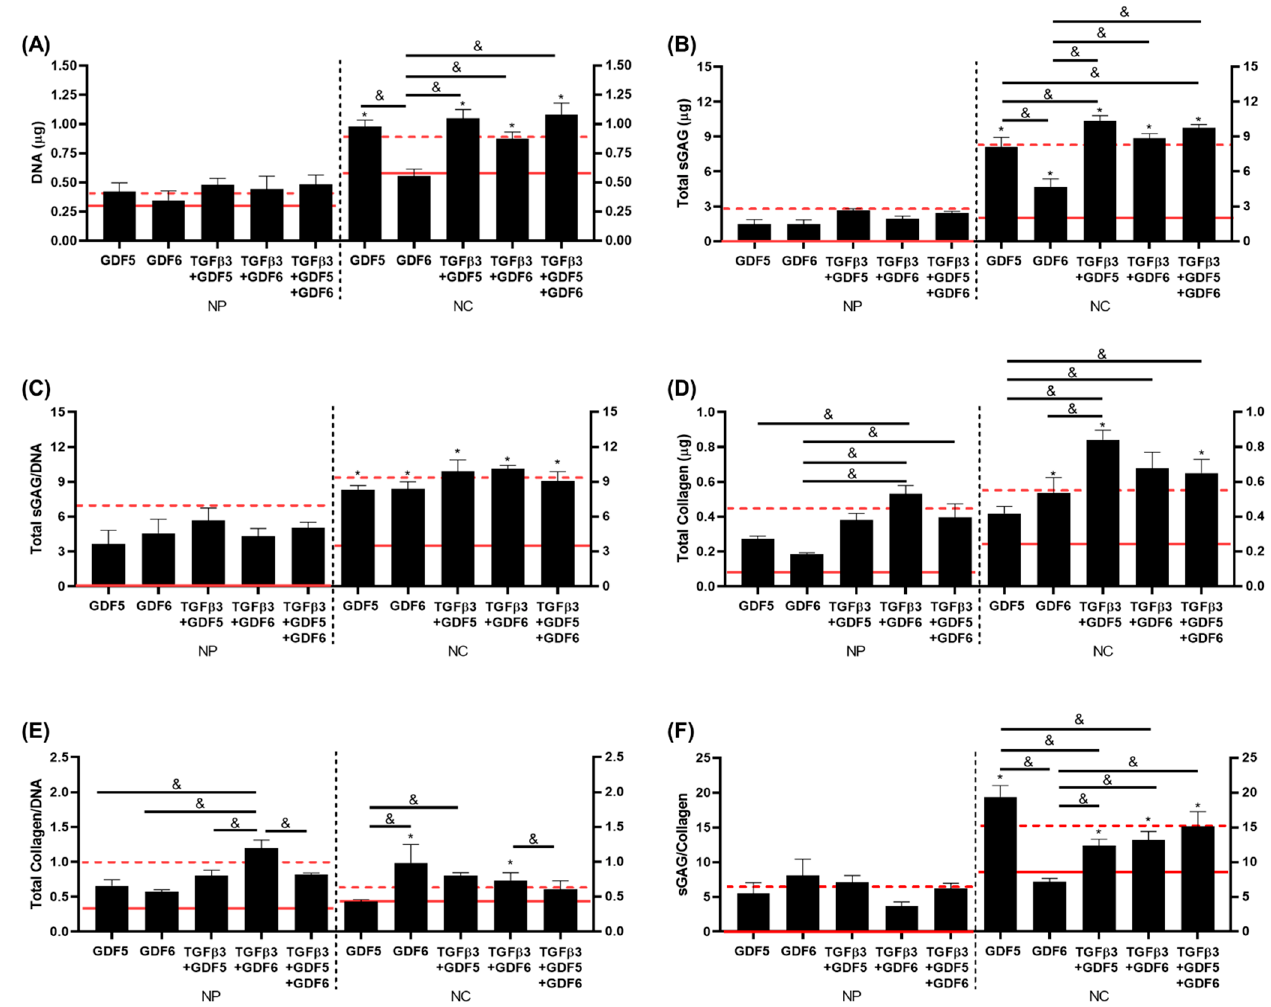
Figure 6. Biochemical analysis of nucleus pulposus (NP) and nasoseptal chondrocyte (NC) micro- tissues stimulated with GDF5, GDF6, TGF β 3 + GDF5, TGF β 3 + GDF6, TGF β 3 + GDF5 + GDF6 on day 7. ( A ) DNA ( µ g), ( B ) Total sGAG ( µ g), ( C ) Total sGAG/DNA, ( D ) Total Collagen ( µ g), ( E ) Total Collagen/DNA and ( F ) sGAG/Collagen ratio. & ( p < 0.05) indicates significance compared to other growth factors in the same experimental group, * ( p < 0.05) indicates significance compared to the NP microtissues for the same growth factor group. Solid red line indicates no growth factor treatment group (control); red dashed line indicates TGF β 3 stimulation